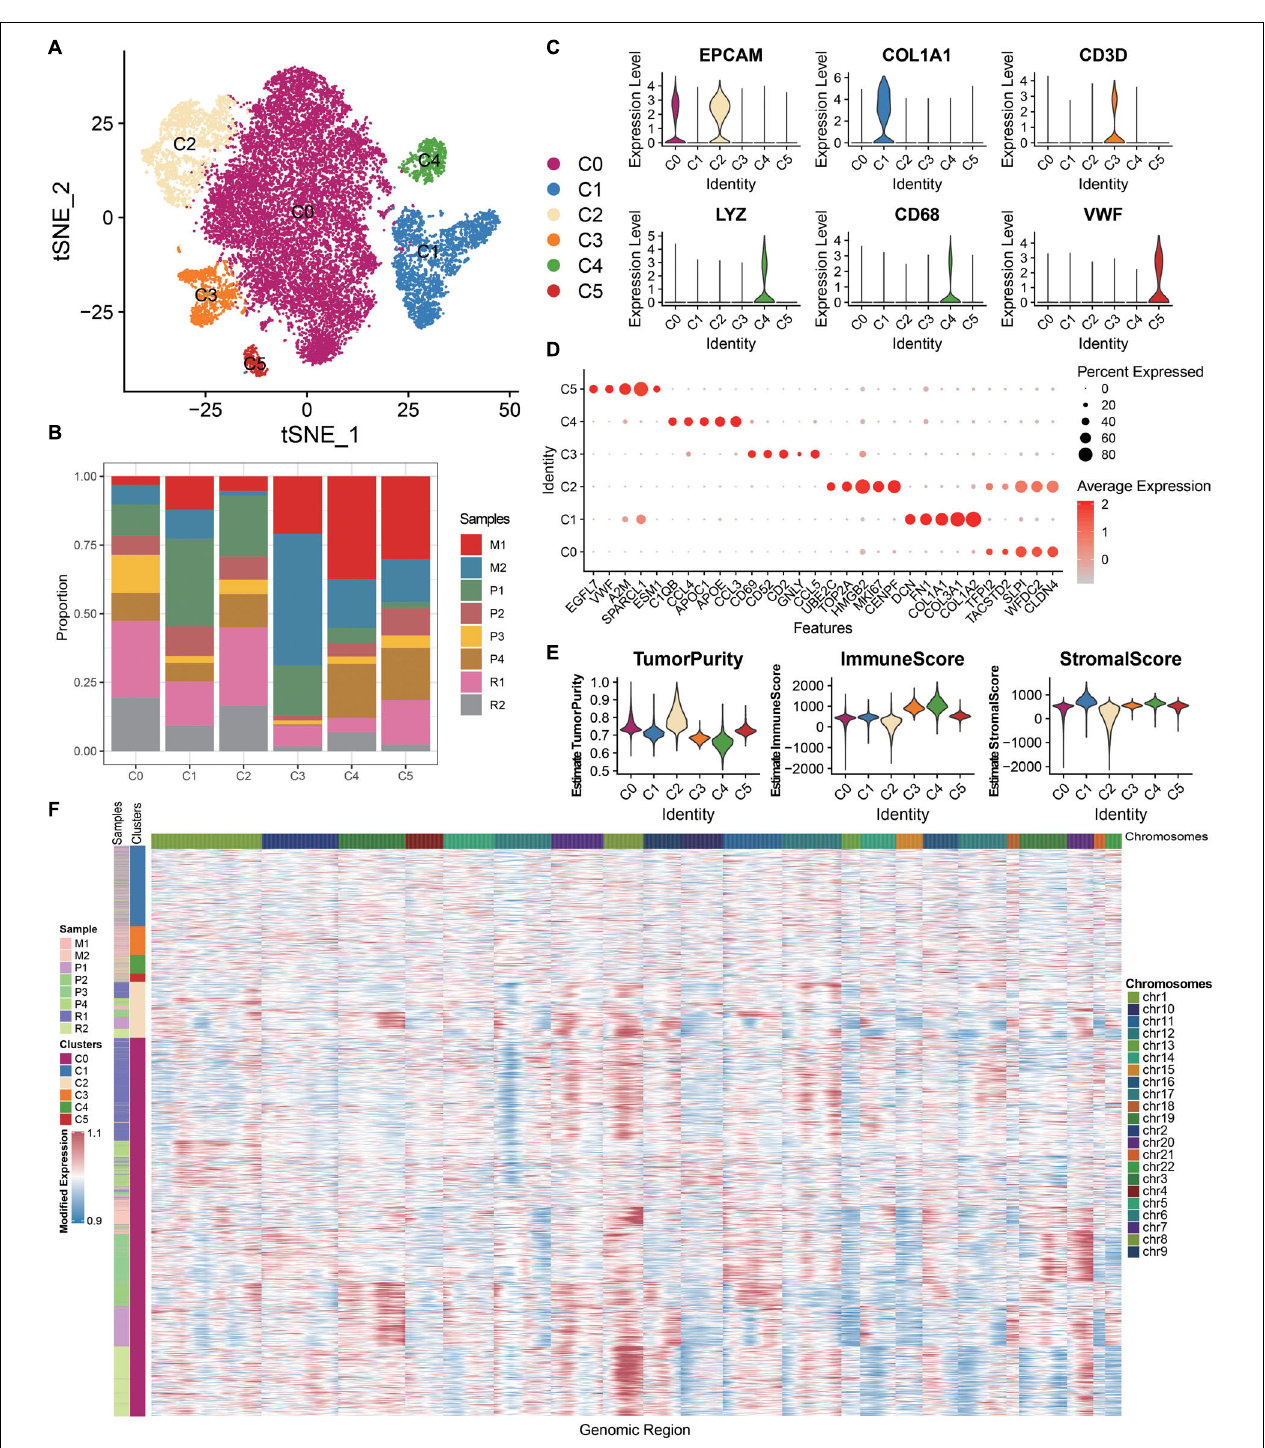
FIGURE 1 | ScRNA-seq profiling of the primary, metastatic, and relapsed OCs. (A) tSNE plot annotating six major cell types in OCs. (B) Histogram indicating the proportion of diverse cell types across different sample origins. (C) Violin plots exhibiting the expression of representative markers across diverse cell types. The y -axis was the normalized read count. (D) Dot plot showing the expression of the top five markers in each indicated cell types. (E) Violin plots illustrating the estimation of tumor purity, immune score, and stromal score across different cell types. (F) Chromosomal landscape of inferred large-scale CNVs distinguishing malignant epithelial cells from other